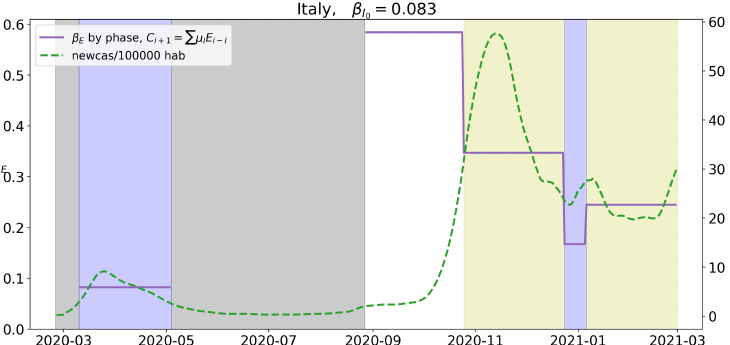
Figure 22. Value of β E for the different levels of lockdown. Blue background will correspond to Stage 1, red to Stage 2, yellow to Stage 3 and white to Stage 4. A green dotted line corresponds to the value of new cases per 100,000 hab.